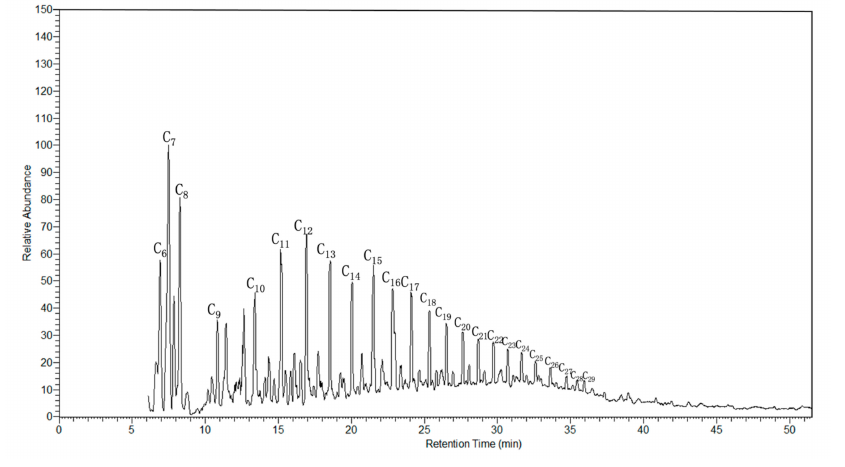
Figure 4. GC-MS curves of oil fraction of Tarim crude.